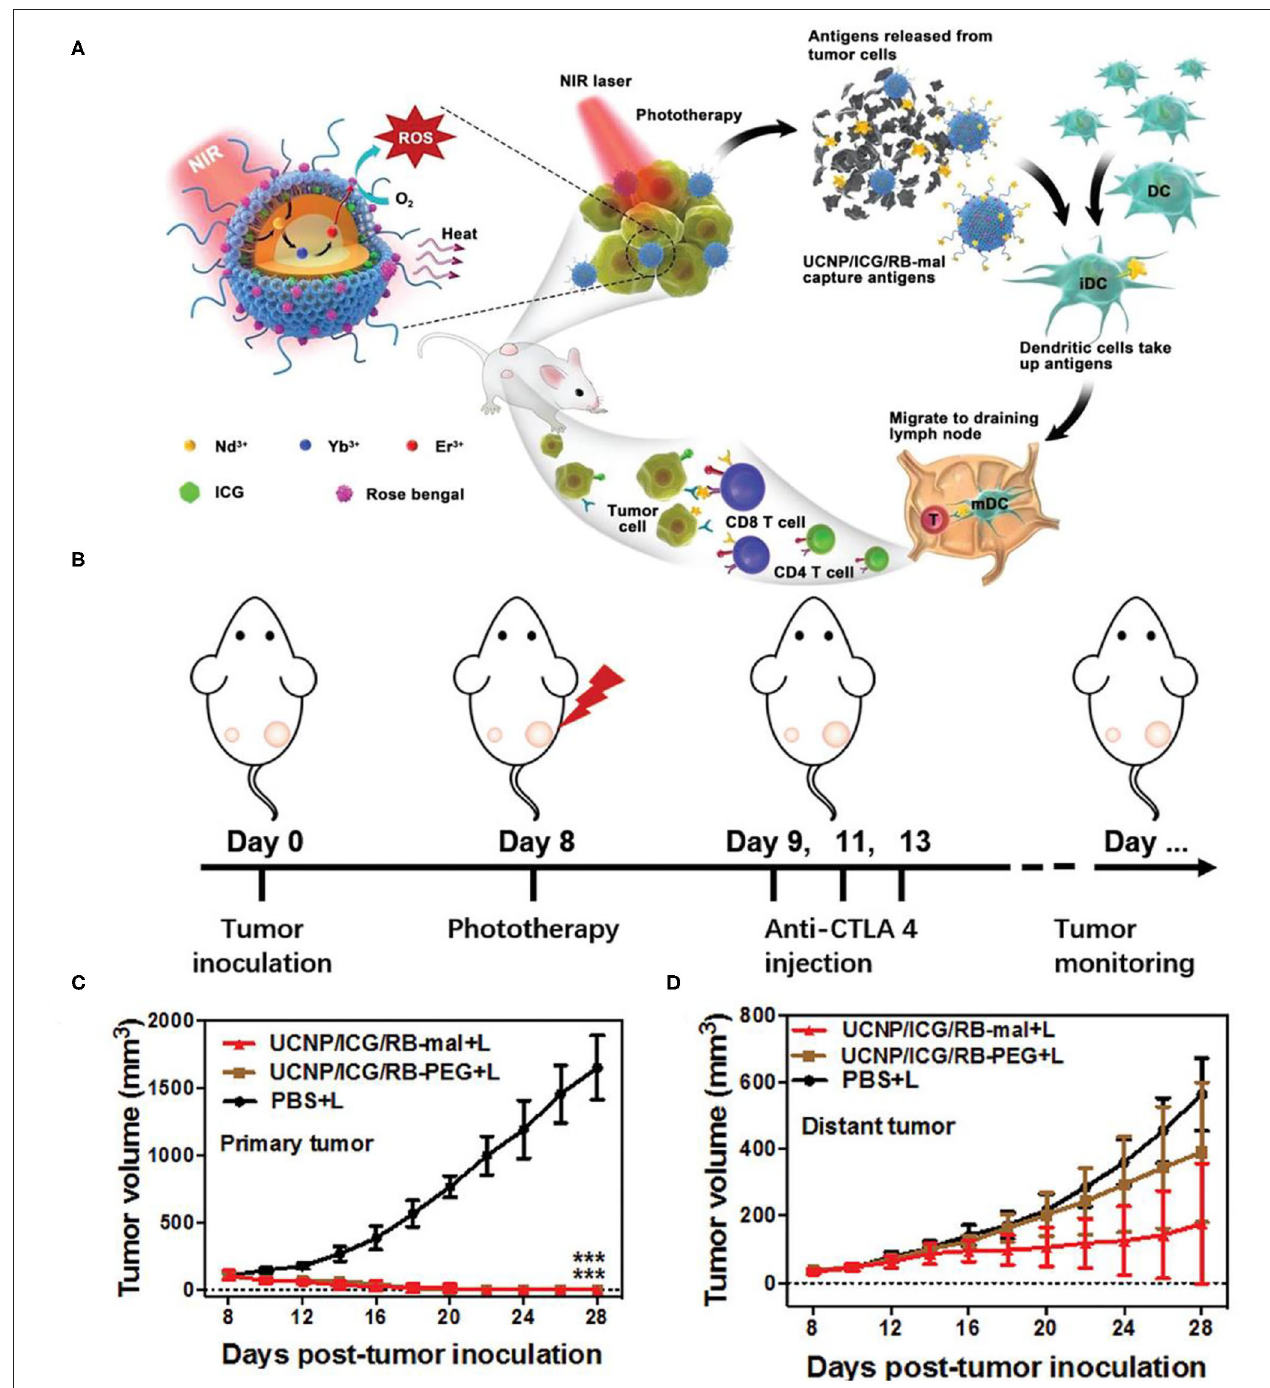
FIGURE 6 | (A) Schematic illustration of both fabrication and mechanism of NIR-triggered antigen-capturing nanoplatform for synergistic photo-immunotherapy. Abscopal effect of UCNP/ICG/RB-mal based phototherapy in combination with checkpoint inhibition for simultaneously inoculated tumors. (B) Schematic depiction of the experimental approach for the evaluation of the abscopal effect induced by UCNP/ICG/RB-mal based phototherapy. (C) Growth curves of primary tumors of mice after various treatments (*** P < 0.001 vs. PBS + L group) (D) Growth curves of distant tumors on mice in different treated groups. Data are expressed as mean ± SD ( n = 5). Copyright 2019, Wiley-VCH (Wang et al., 2019a).